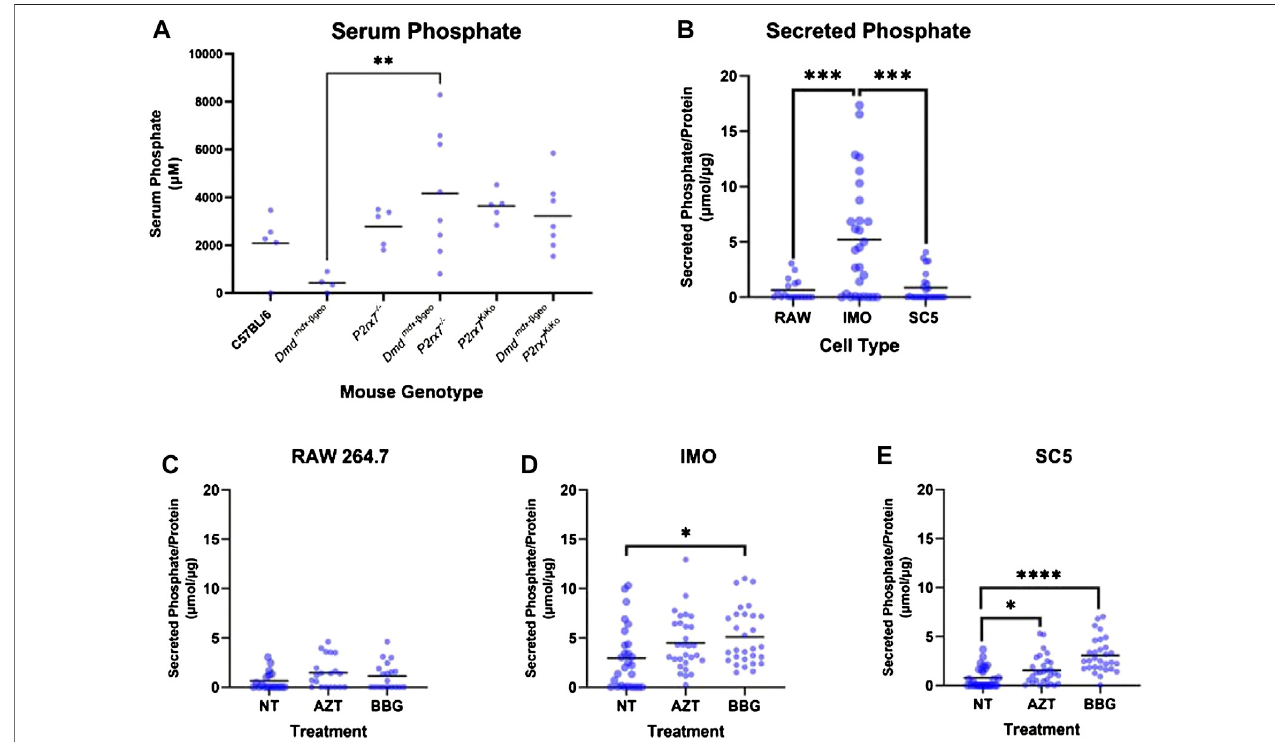
FIGURE 4 | Phosphate in serum and cell conditioned media. Phosphate was measured from mouse serum and cell conditioned media using the malachite green assay. (A) Serum phosphate was higher in Dmd mdx- β Geo P2rx7 − / − compared to Dmd mdx- β Geo but not Dmd mdx- β Geo P2rx7 KiKo mice (** = p < 0.01, Ordinary one-way ANOVA with Holm- Š ídák ’ s multiple comparison test). (B) Phosphate levels were higher in cell conditioned media (CM) from IMO cells than from either RAW cells or SC5 cells ( p < 0.001, Univariate analysis in SPSS with Tukey ’ s post-tests). (C) Phosphate secretion by RAW cells was unaltered by treatment with the P2x7 inhibitors AZT and Coomassie brilliant blue G (BBG). (D) Phosphate secretion by IMO cells was increased in the presence of BBG (* = p < 0.05, Univariate analysis in SPSS with Tukey ’ spost-tests). (E) PhosphatesecretionbySC5cellswasincreasedinthepresenceofAZT(*= p < 0.05)andBBG(****= p < 0.0001,UnivariateanalysisinSPSSwith Tukey ’ s